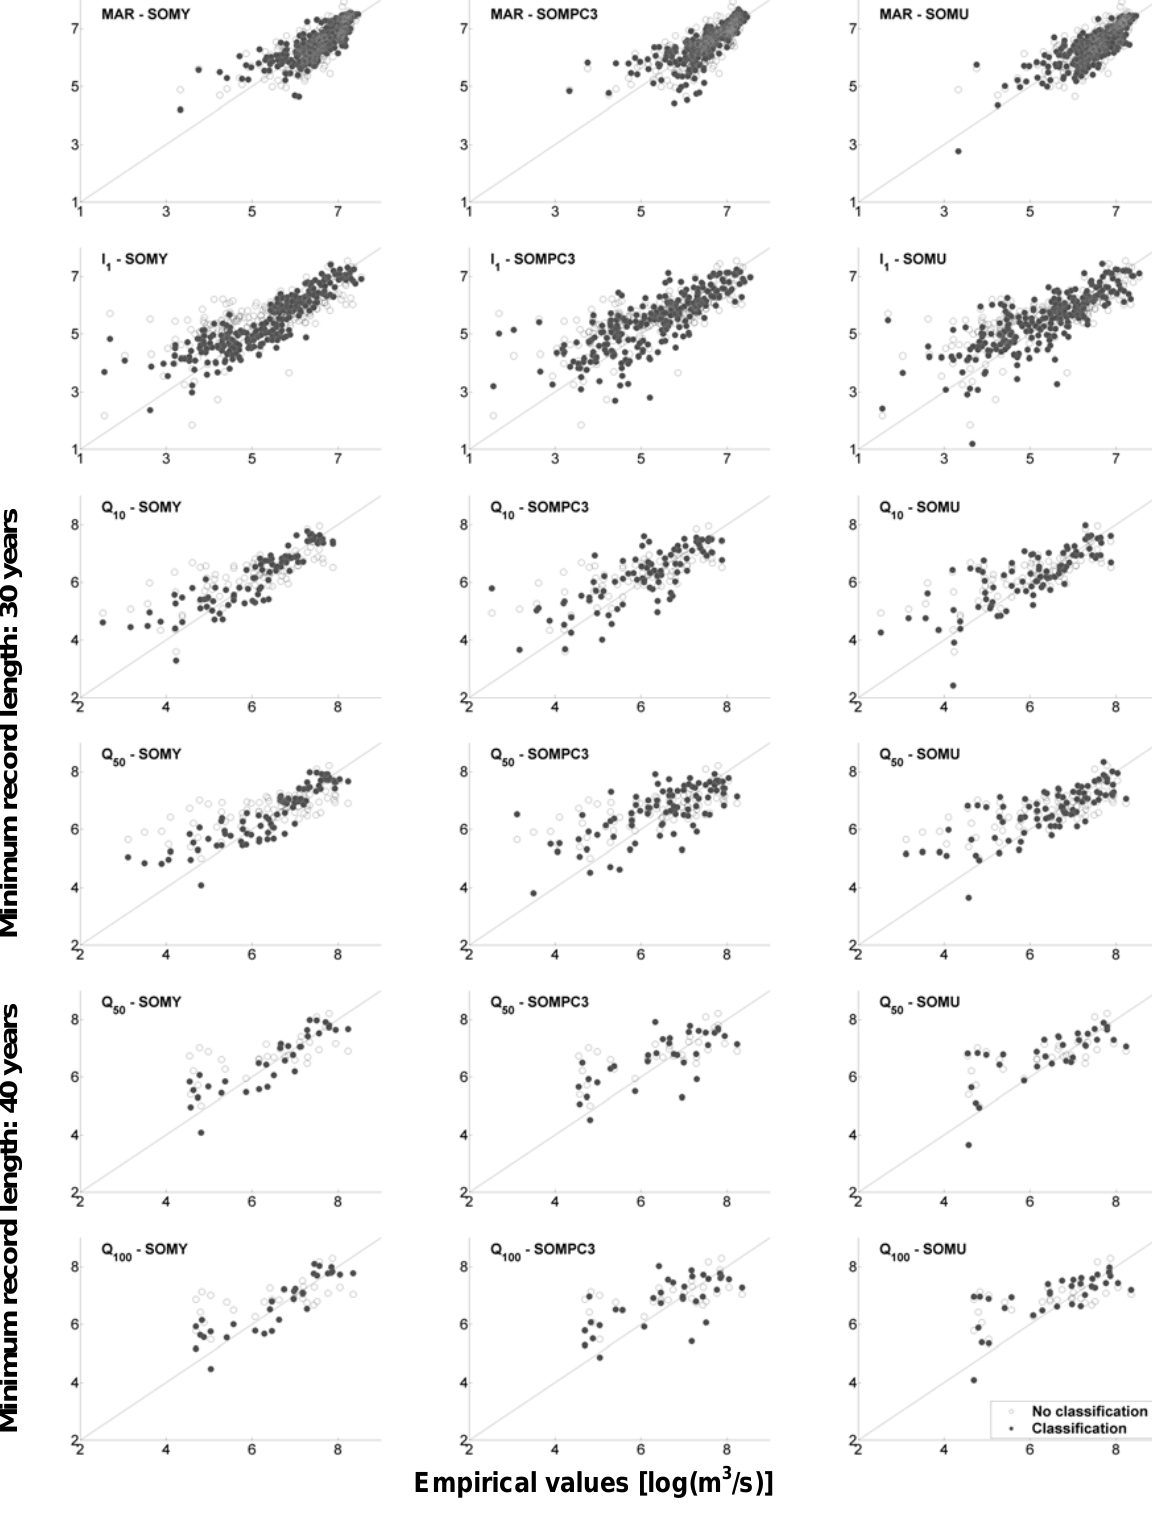
Fig. 8. Examples of scatter-plots (empirical vs. jack-knife values) obtained in cross-validation for some of the classifications considered in the study (the baseline classification NO-CLASS is reported in grey in each